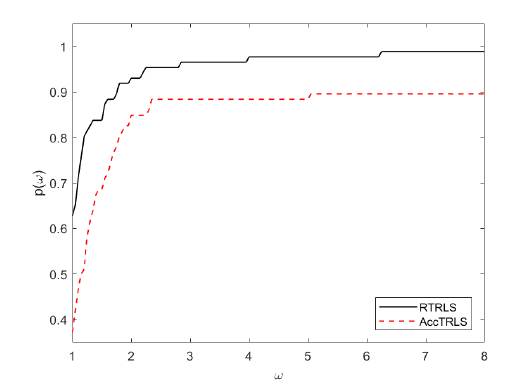
Figure 4. CPU time performance